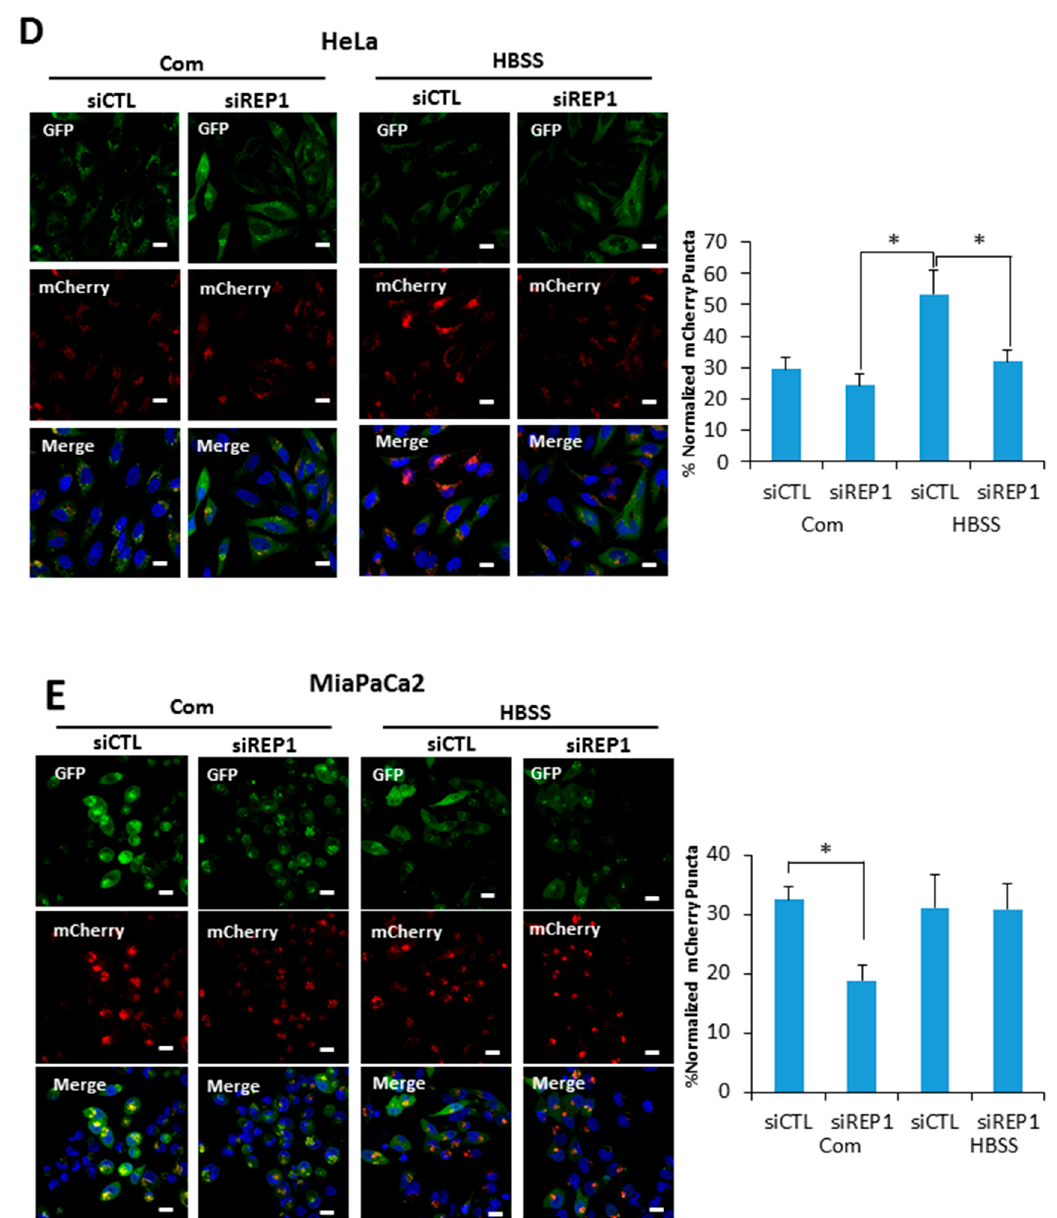
Figure 3. REP1 depletion suppresses starvation-induced autophagy. ( A ) Hela and MiaPaCa2 cells stably expressing GFP-LC3 with a retroviral vector system were treated with CTL or REP1 siRNA and incubated for 48 h. Then, after 2 h of incubation in amino acid-deprived media, cells were harvested and immunoblotted for LC3, P62, and GFP. These results are representative of more than three independent experiments. GFP-LC3 puncta were analyzed by live imaging using fluorescence microcopy in ( B ) Hela and ( C ) MiaPaCa2 cells. Scale bar: 20 µ m. Quantification data for GFP-LC3 puncta area are expressed as a percentage of the DAPI area within the cell. Hela and MiaPaCa2 cells stably expressing mCherry-GFP-LC3 with a retroviral vector system were treated with CTL or REP1 siRNA and incubated for 48 h. Then, after 2 h of incubation in Hank’s balanced saline solution (HBSS) media, mCherry puncta from mCherry-GFP-LC3 were imaged by fluorescence microcopy in ( D ) Hela and ( E ) MiaPaCa2 cells. Scale bar: 20 µ m. Quantification data for mCherry puncta area derived from mCherry GFP-LC3 are expressed as a percentage of the DAPI area within the cell. Images shown are representative of at least three independent experiments. Statistical significance was determined via t -test; * p < 0.05.